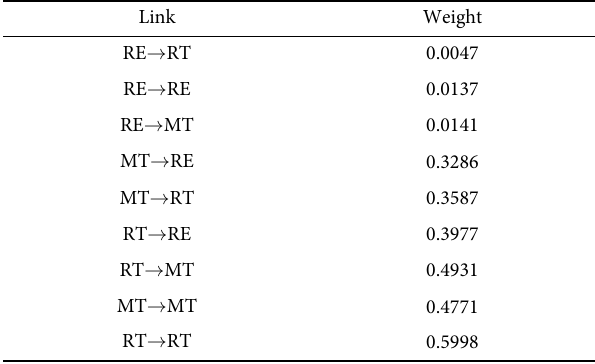
Table 3 Weights of all links of the HCG for the Twitter dataset when k=3.